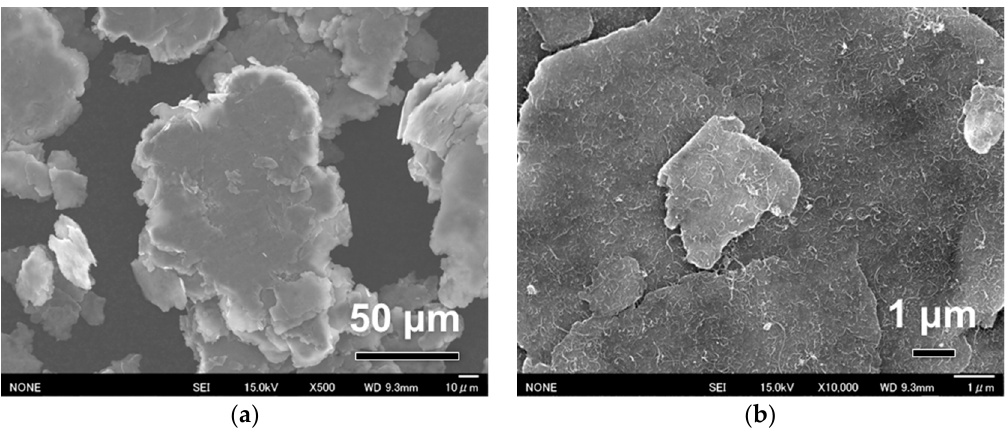
Figure 2. Morphology of CNT–Al composite powder dispersed by mechanical coating process at different magnifications: ( a ) Flattened surfaces were produced of flaky Al powders; ( b ) CNTs were uniformly distributed on the flaky powder surface.